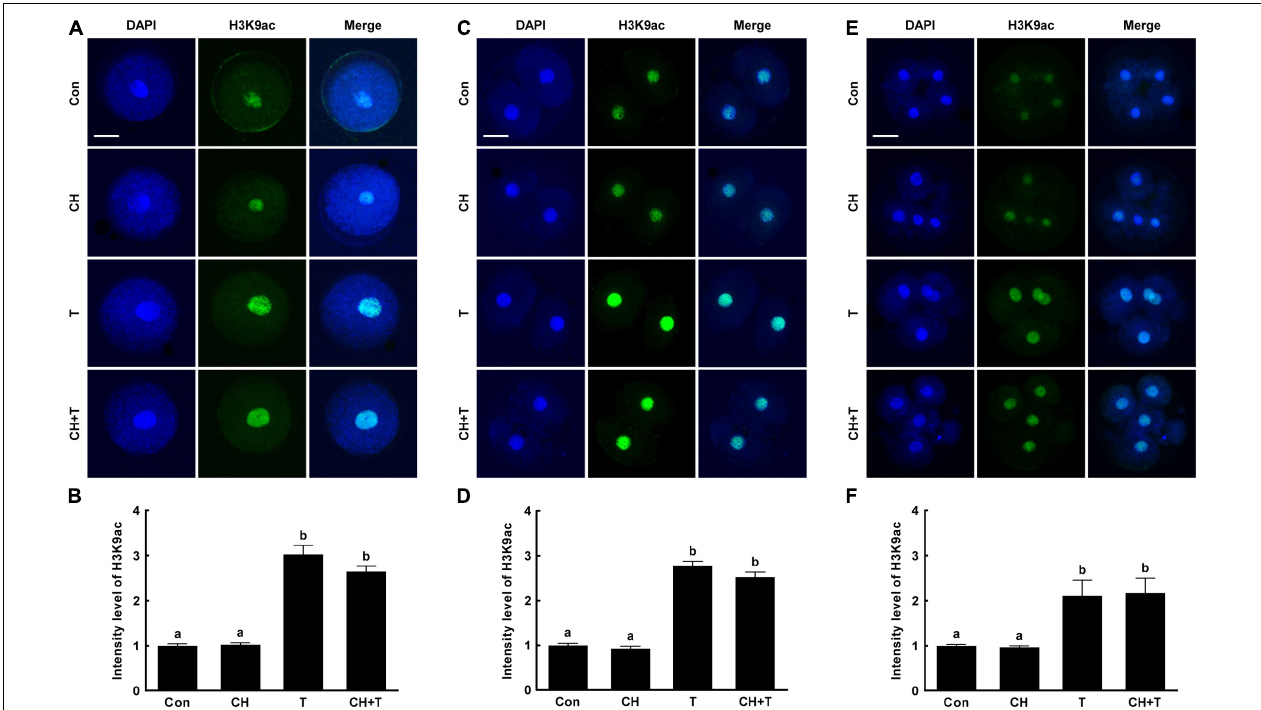
FIGURE 4 | Effects of chaetocin, TSA, and the combination on H3K9ac levels in porcine SCNT embryos. (A) Representative immunofluorescent images of H3K9ac at the pronuclear stage. Green and blue fluorescence indicate H3K9ac and nuclei, respectively. Bar = 50 µ m. (B) Quantification of fluorescence intensity at the pronuclear stage ( n = 20 per group). (C) Representative immunofluorescent images of H3K9ac at the two-cell stage. Green and blue fluorescence indicate H3K9ac and nuclei, respectively. Bar = 50 µ m. (D) Quantification of fluorescence intensity at the two-cell stage ( n = 20 per group). (E) Representative immunofluorescent images of H3K9ac at the four-cell stage. Green and blue fluorescence indicate H3K9ac and nuclei, respectively. Bar = 50 µ m. (F) Quantification of fluorescence intensity at the four-cell stage ( n = 18 per group). The data are from three independent experiments and are means ± SEM. Values with different superscripts differ significantly ( P < 0.05). Con, control; CH, chaetocin; T,